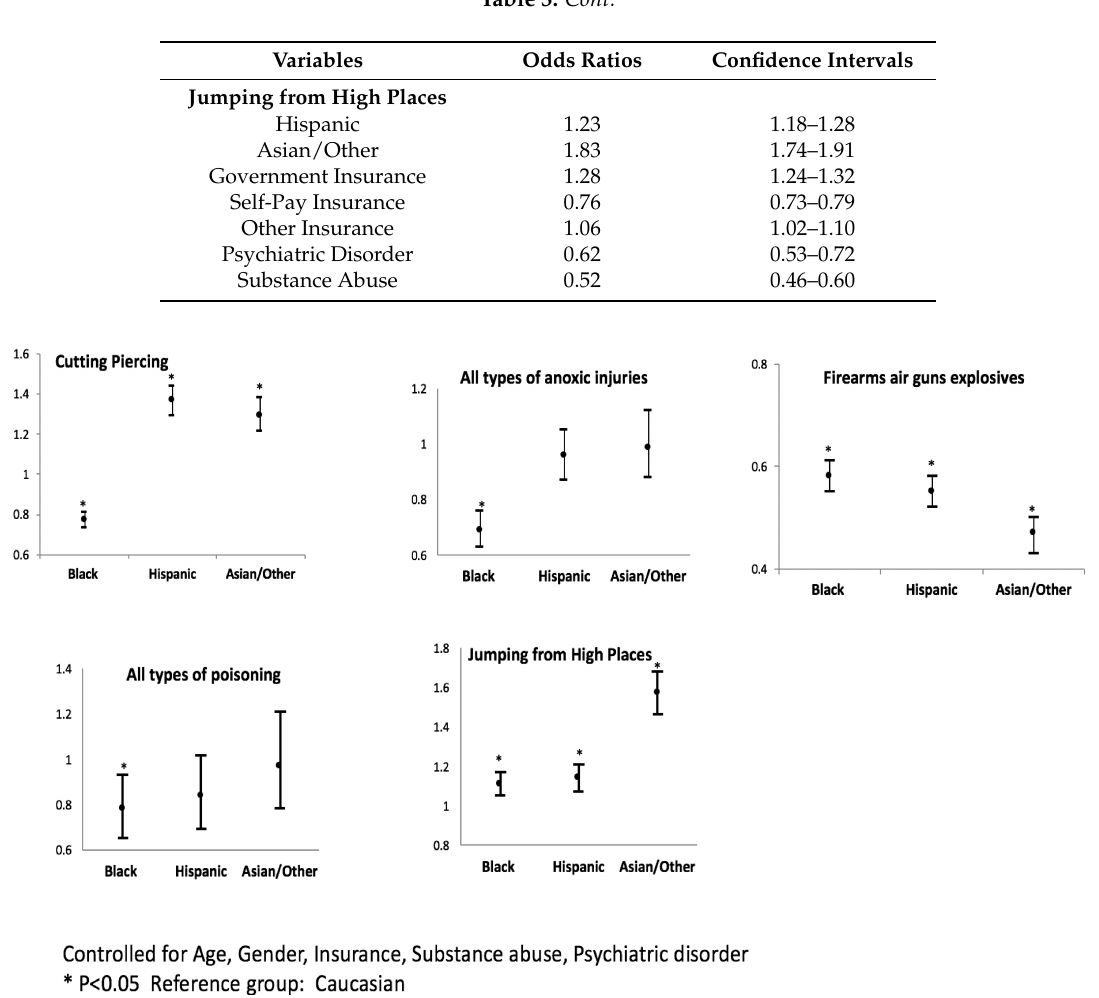
Figure 1. Association of race/ethnicity with various methods of self-inflicted injury (graphs show odds ratio with their 95% confidence intervals).